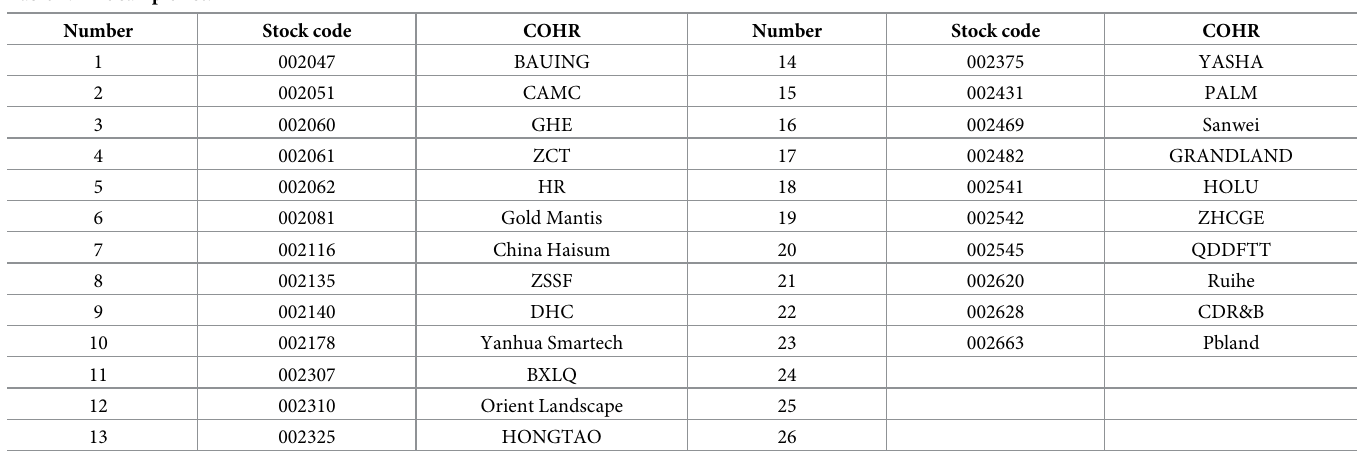
Table 2. The sample list.